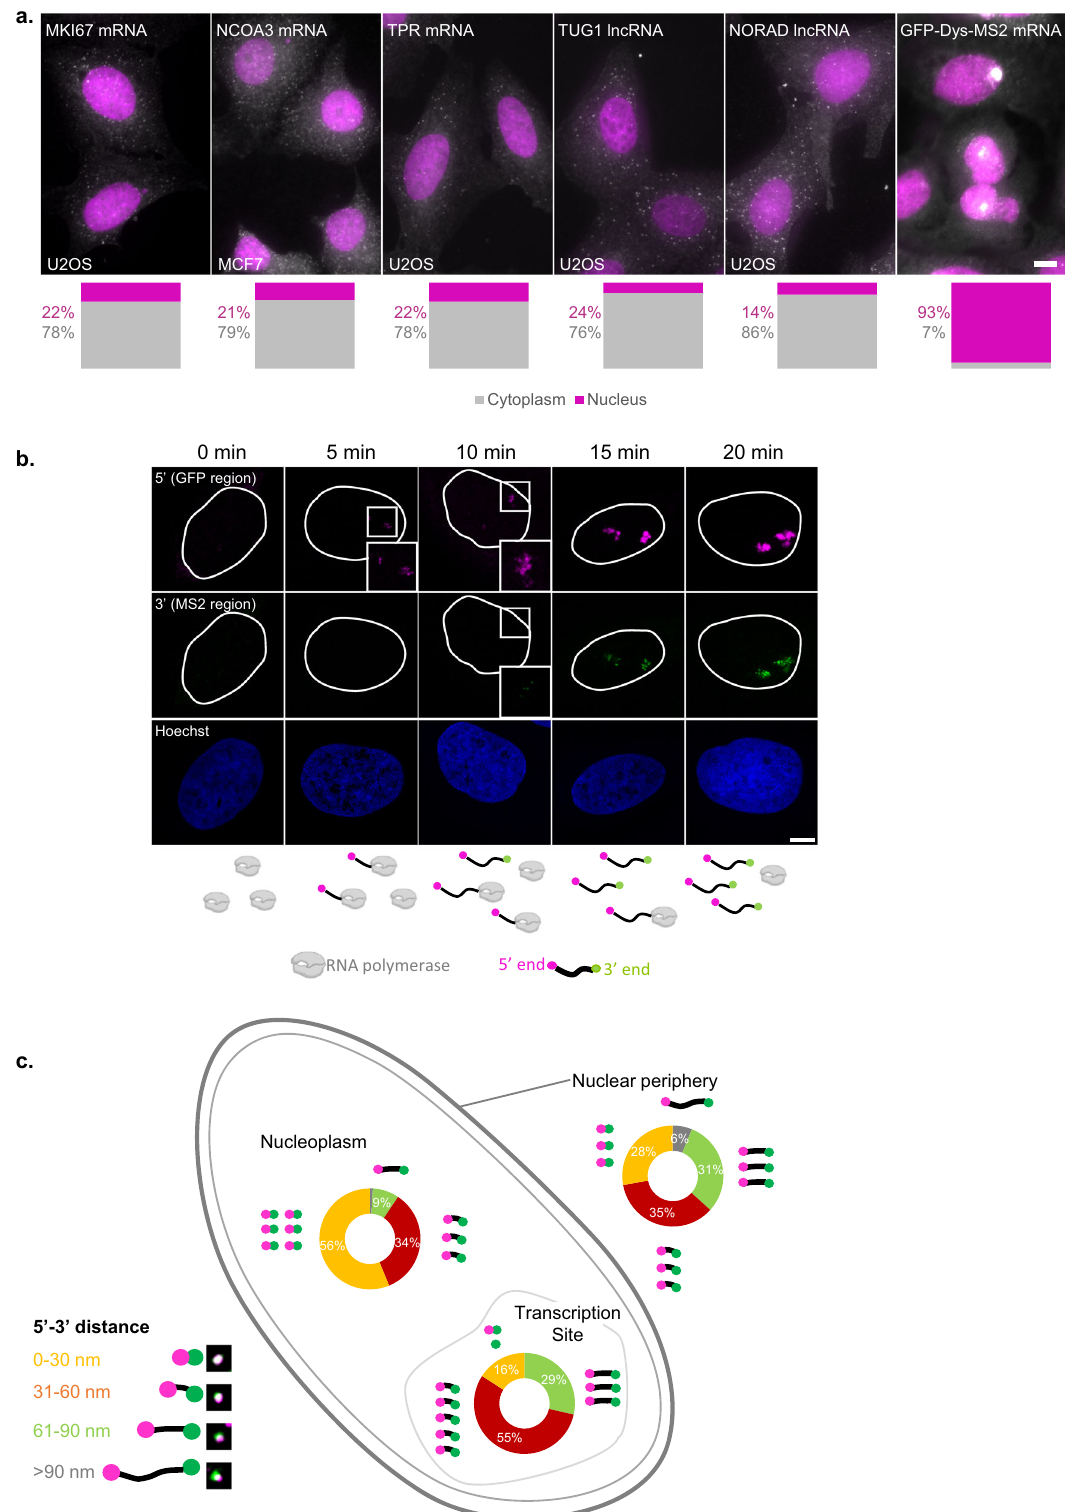
Fig. 1 | mRNAs change their compaction state during travels through the nucleus. a Wide- fi eld images showing RNA smFISH on fi ve different mRNA and lncRNA transcripts (white) along with nuclei (magenta) in U2OS and MCF7 cells. Cytoplasm/nucleus (C/N) ratios for each transcript (gray — cytoplasm, magenta — nucleus) are presented below ( n =30 cells for each transcript). Scale bar, 10 µ m. b Confocal images showing activated sites of transcription where the 5 ’ -end (magenta)of GFP-Dys isthe fi rstto betranscribed,followed by3 ’ -end (green).The outlines of the nuclei were traced from the Hoechst images. Boxed areas are